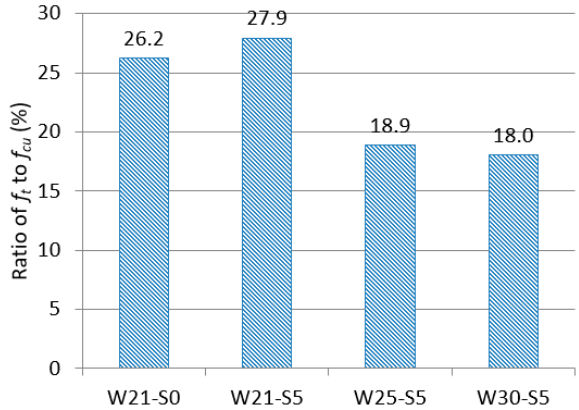
Figure 7. Ratio of tensile strength to compressive strength.